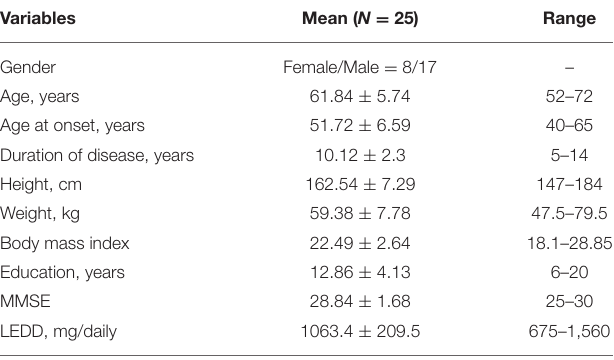
TABLE 1 | Demographic characteristics of the patients with